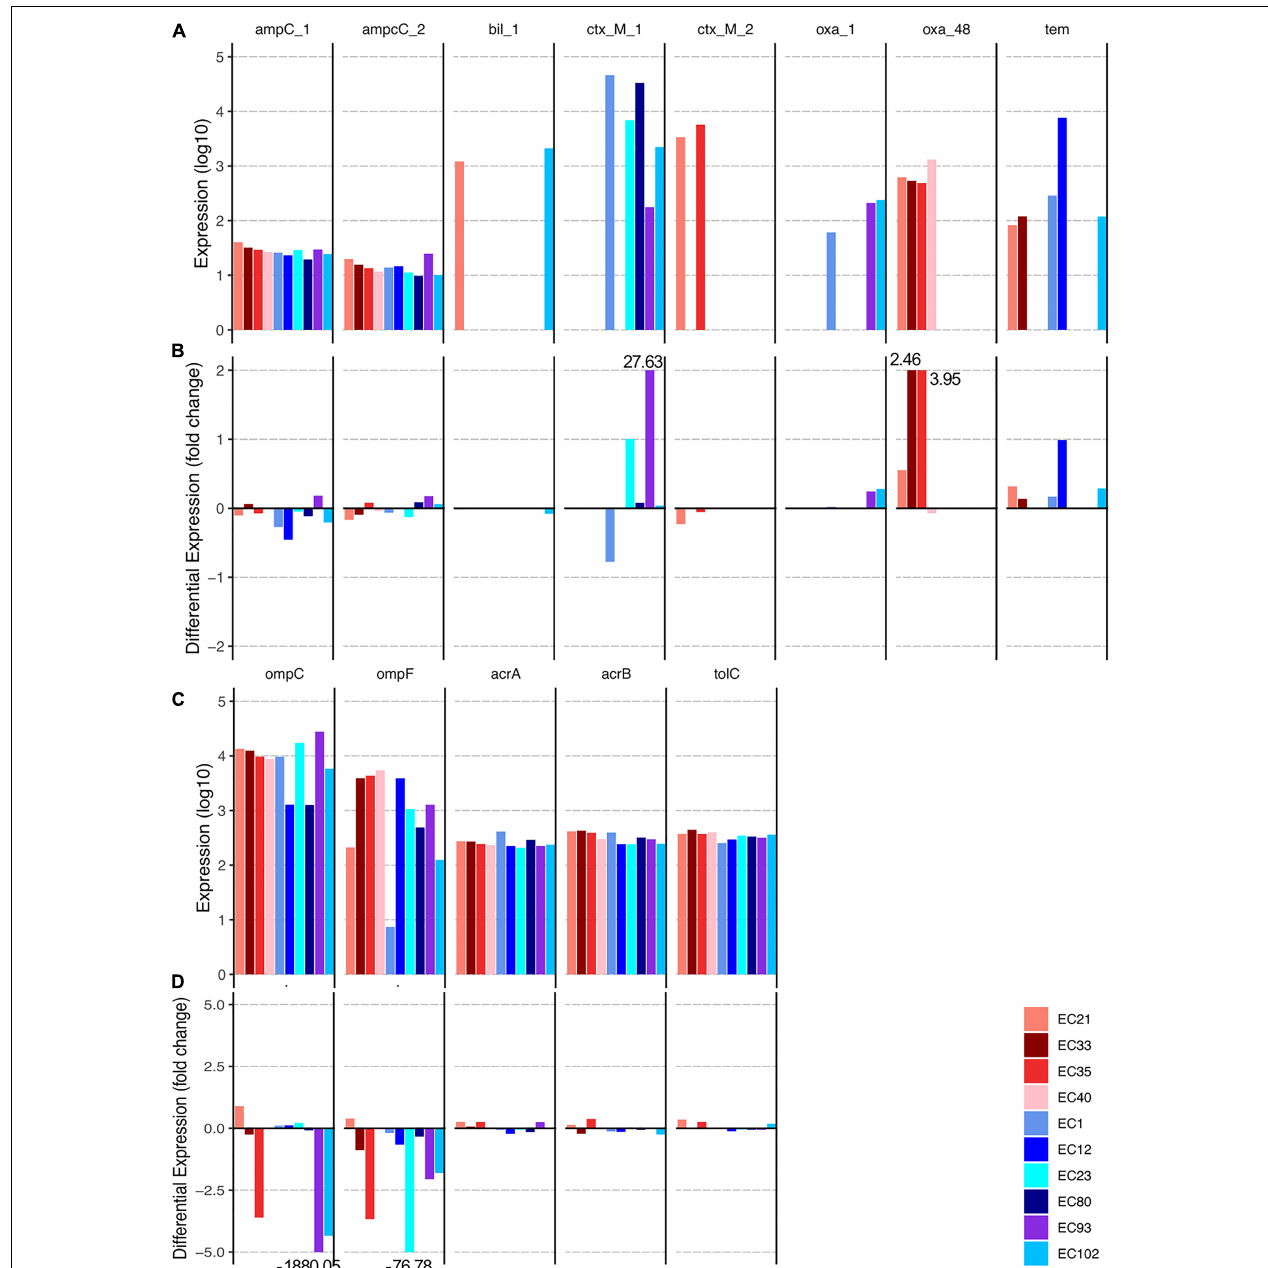
FIGURE 4 | (Differential) expression results of genes reported to play a key role in resistance to carbapenems are shown. Panels (A,B) give expression results of genes encoding ß-lactamases, including the carbapenemase Oxa-48, whereas expression of genes encoding the porins OmpC and OmpF and of proteins that form the AcrAB-TolC efflux pump are shown in panels (C,D)